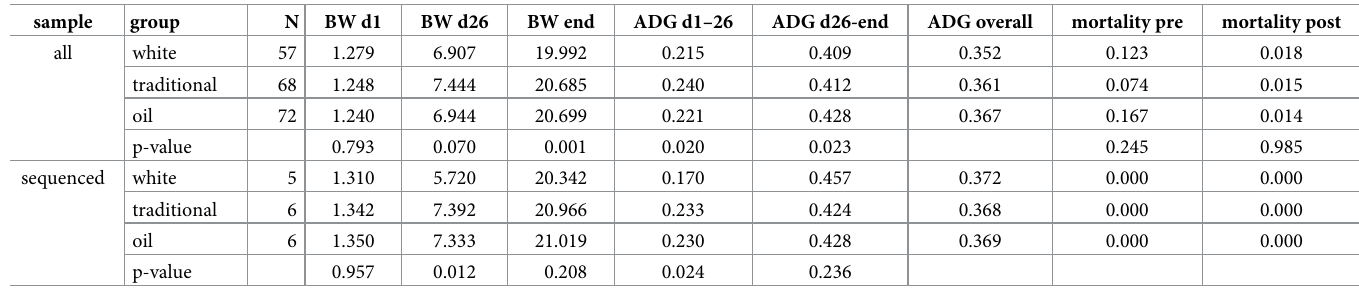
Table 1. Mortality, growth performance and individual therapeutic treatments in piglets from the three groups (white diet, traditional diet, oil diet). sample group mortality pre mortality